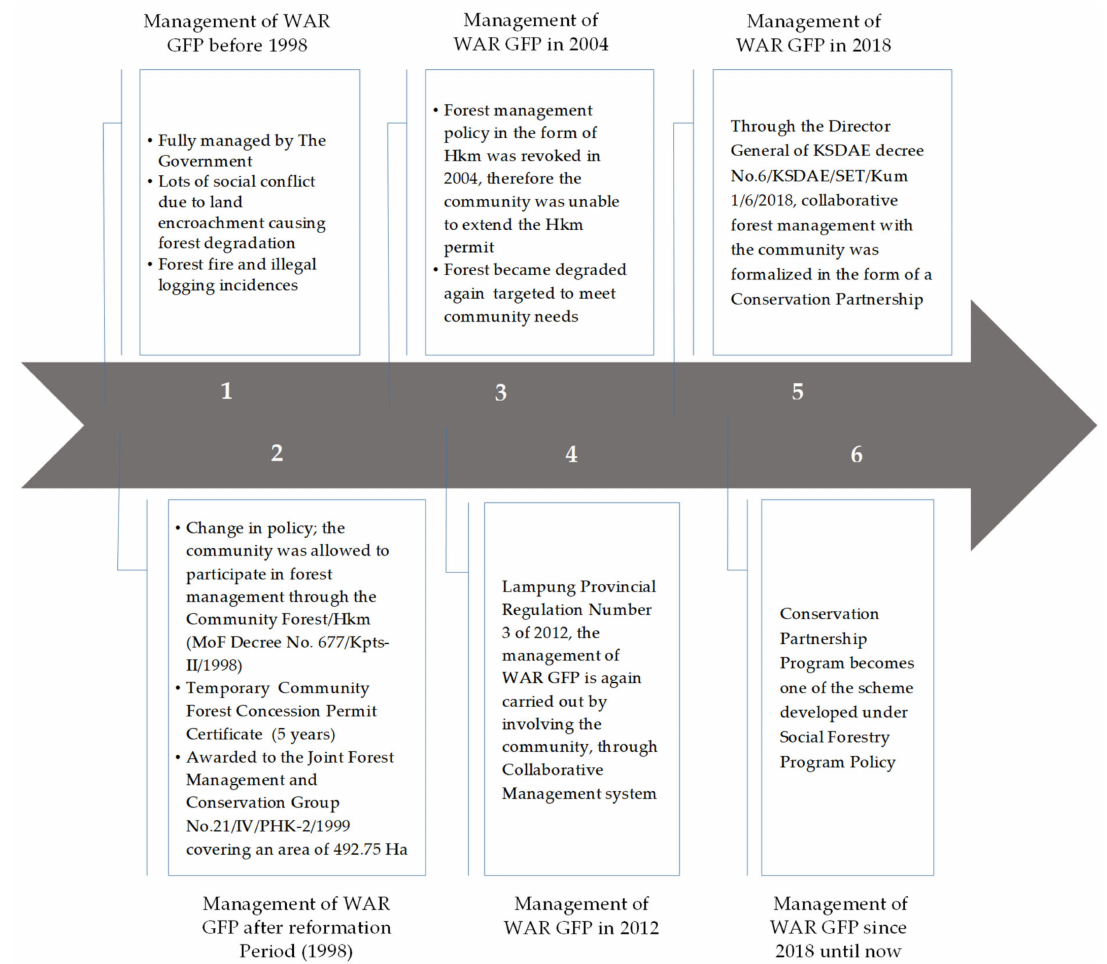
Figure 2. Management dynamics of Wan Abdul Rachman Grand Forest Park (WAR